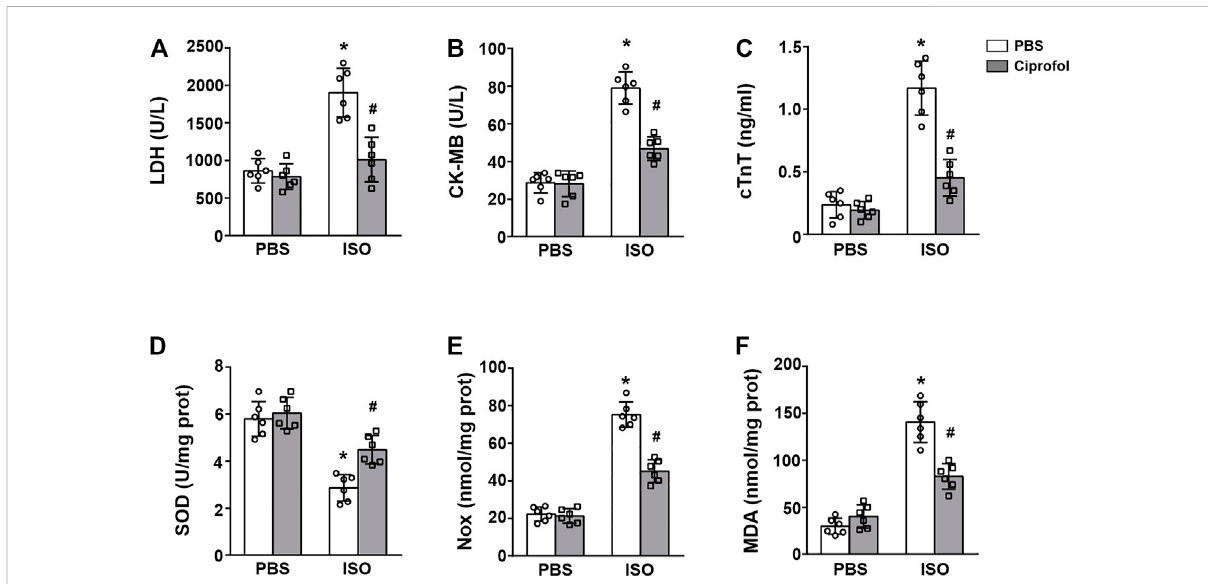
FIGURE 6 Ciprofol treatment blunted ISO-induced myocardial damage and oxidative stress in vitro . CK-MB (A) , LDH (B) and cTnT (C) activities in each group were detected ( n = 6). SOD (C) , NOX (D) and MDA (E) levels in each group were assessed ( n = 6). p p < 0.05 compared to the PBS group. # p < 0.05 compared to the ISO group.